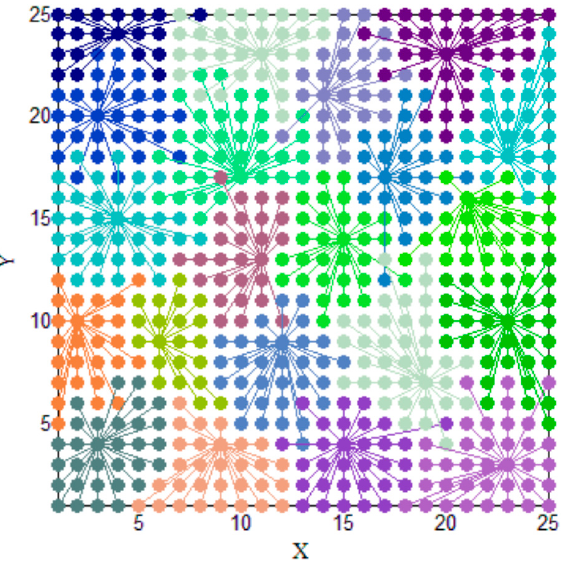
Figure 15. The clustering of Ψ .